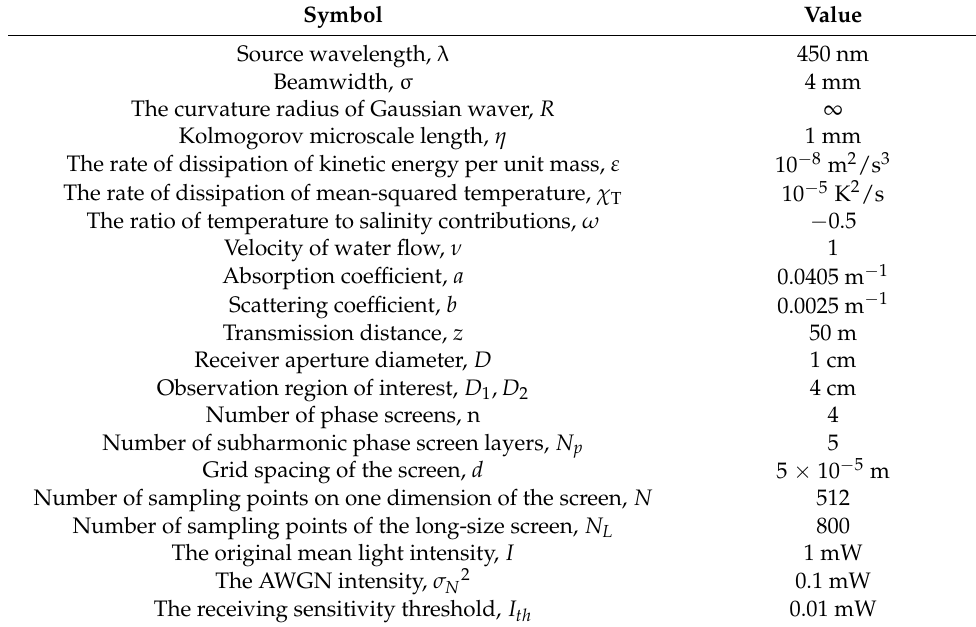
Table 1. Parameter values in the simulation. Symbol Value Source wavelength, λ 450 nm Beamwidth, σ 4 mm The curvature radius of Gaussian waver, R ∞ Kolmogorov microscale length, η 1 mm The rate of dissipation of kinetic energy per unit mass, ε 10 − 8 m 2 /s 3 The rate of dissipation of mean-squared temperature, χ T 10 − 5 K 2 /s The ratio of temperature to salinity contributions, ω − 0.5 Velocity of water flow, ν 1 Absorption coefficient, a 0.0405 m − 1 Scattering coefficient, b 0.0025 m − 1 Transmission distance, z 50 m Receiver aperture diameter, D 1 cm Observation region of interest, D 1 , D 2 4 cm Number of phase screens, n 4 Number of subharmonic phase screen layers, N p 5 Grid spacing of the screen, d 5 × 10 − 5 m Number of sampling points on one dimension of the screen, N 512 Number of sampling points of the long-size screen, N L 800 The original mean light intensity, I 1 mW The AWGN intensity, σ N 2 0.1 mW The receiving sensitivity threshold, I th 0.01